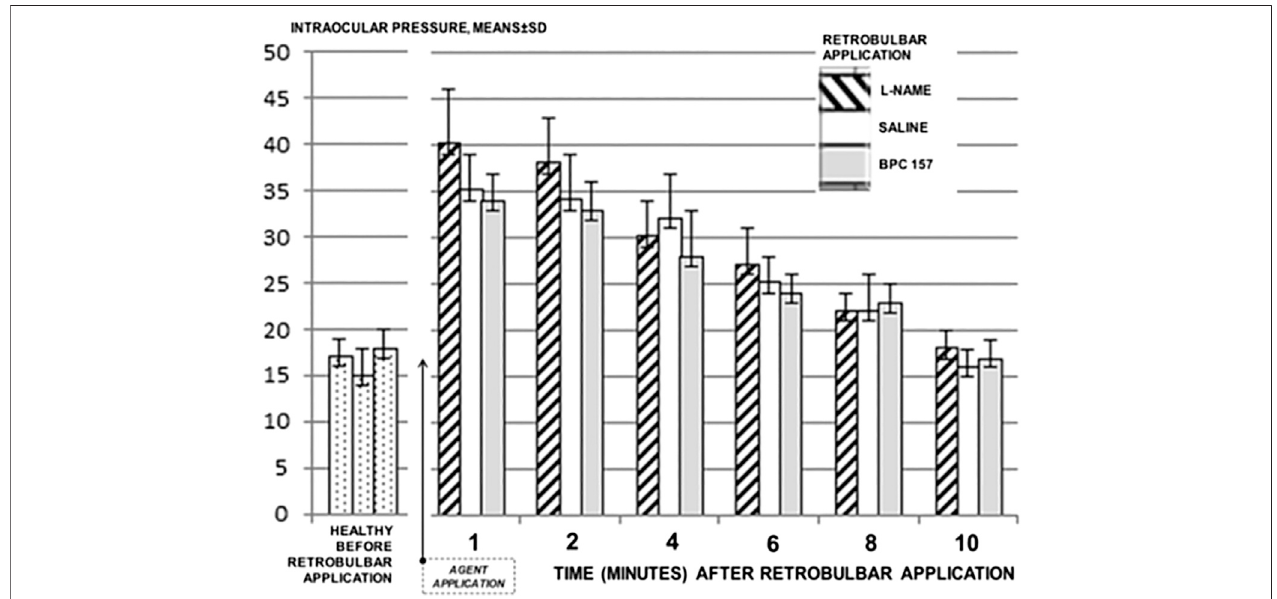
FIGURE1| IntraocularpressurewasmeasuredusingacalibratedapplanationtonometerTonopenXLbyReichertTechnologies(thetransducerwasplacedonthe samespotofthecorneaforeachmeasurement).Intraocularpressurewasassessedinnormalrats,andvaluesbetween13 – 19 mmHgwereconsideredasnormal.Then, the values were assessed before retrobulbar application, and after retrobulbar application of saline (0.1 ml/each eye) (control), BPC 157 1 μ g/0.1 ml saline/each eye, or L-NAME0.5 mg/0.1 mlsaline/eacheye,at 1, 2, 4, 6,8, and 10 minutes thereafter.No difference vs. control wasnoted. 10rats per experimentalgroupand period for all experiments.